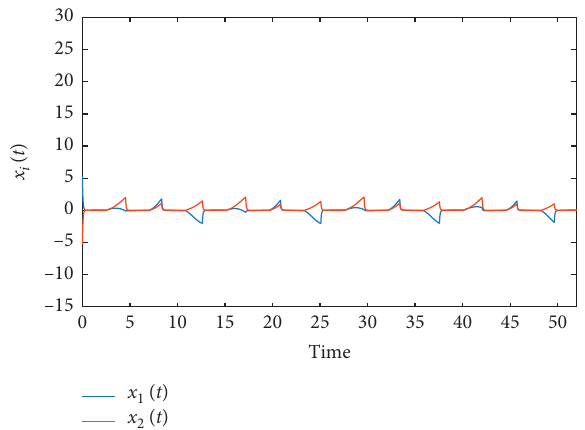
Figure 2: The starting instant of each control of the observer-based T-APIC.